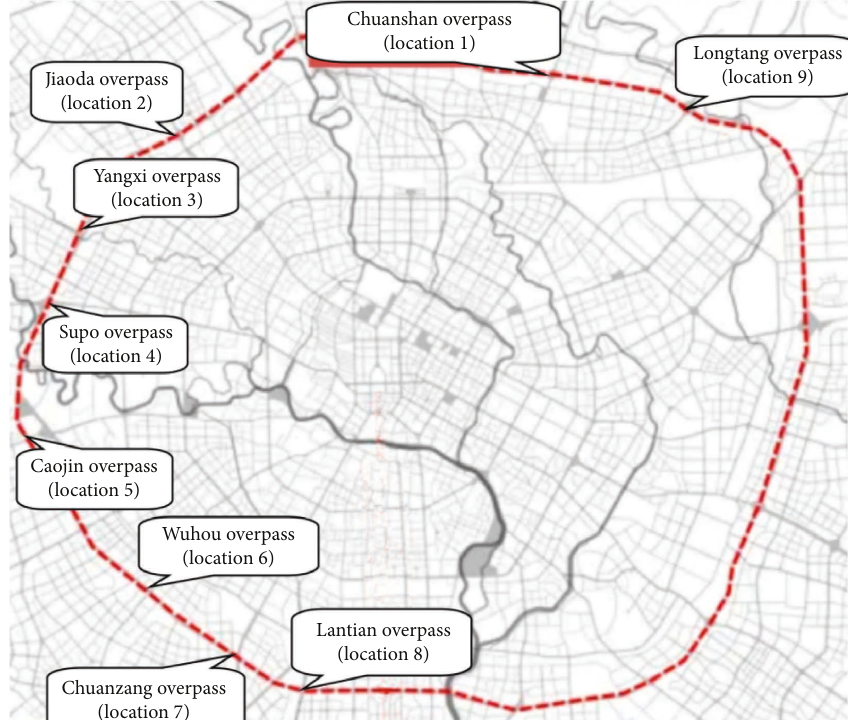
Figure 1: The distribution of locations of shooting videos.